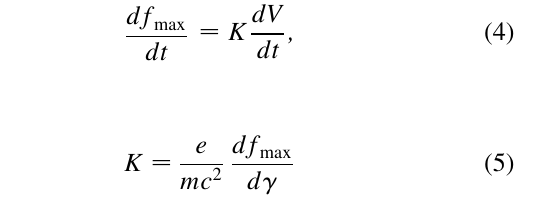
.FIG. 6. (Color) The frequency-pulling effect. At t (cid:2) t (right- 1 hand curve), it is assumed that the radiation is built up in the resonator so that the dominant mode m is excited at the (cid:2) f (cid:5) 0 (cid:6) . As the gain curve maximum-gain frequency: f m max (cid:5) t (cid:6) < shifts to lower frequencies (left-hand curve) f max 2 (cid:5) t (cid:6) , there is a corresponding down-shift in the stored f max 1 due to the frequency-pulling radiation frequency f < f m FIG. 7. (Color) Israeli FEL frequency dependence on the beam accelerating energy (cid:5) (cid:3) – 1 (cid:6) mc 2